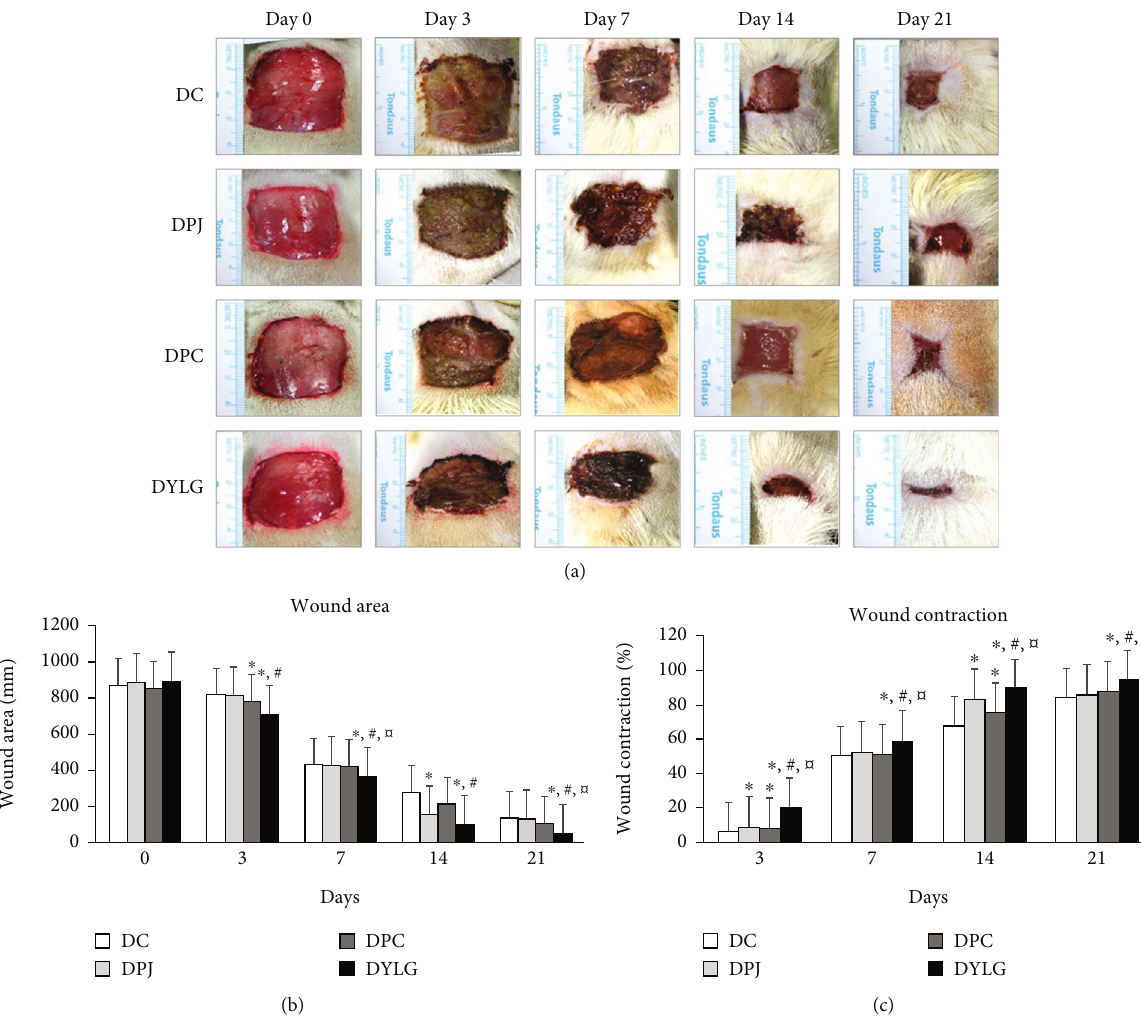
Figure 1: E ff ect of YLG on the wound area and rate of wound contraction in T2DM rats. (a) Representative wound photographs of groups of DC, DPJ, DPC, and DYLG on days 0, 3, 7, 14, and 21. (b) Changes in wound area of T2DM rats. (c) Change in the wound contraction rate of the rats. DC: diabetic control group; DPJ: diabetic negative control group; DPC: diabetic positive control group; DYLG: diabetic Yeliangen-treated group. ∗ p < 0 : 05 as compared to DC group, # p < 0 : 05 as compared to DPC group, and ¤ p < 0 : 05 as compared to DPJ group. The results were represented as mean ± SEM . ∗ The meaning of the symbols in the following fi gures is the same in this study, so they will not be repeated.